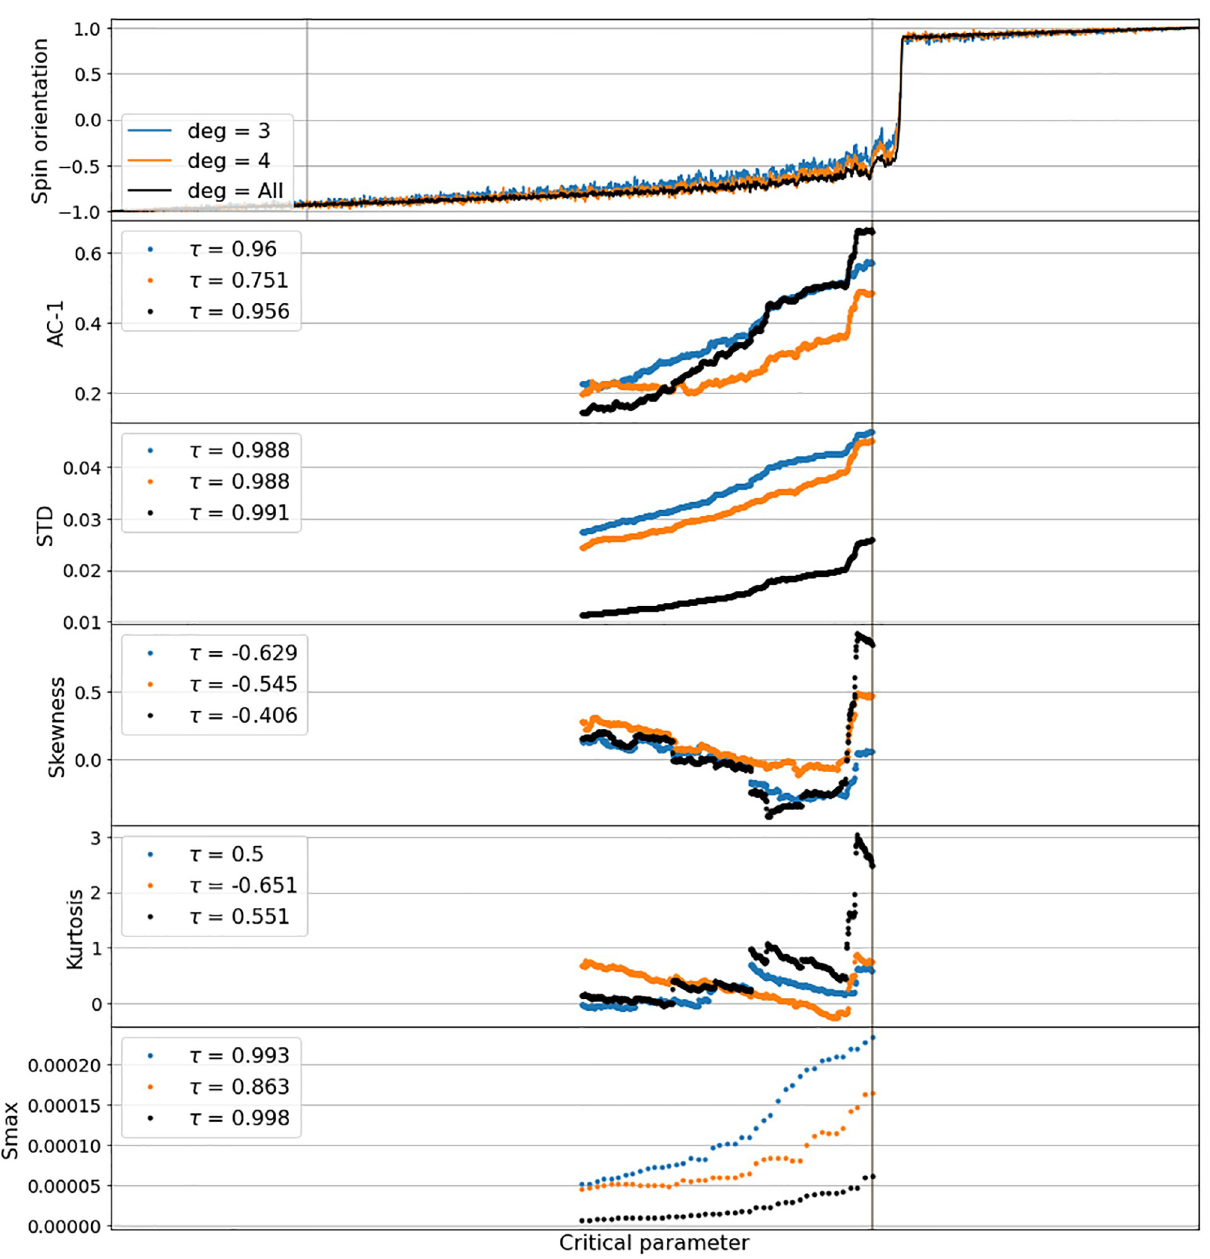
Fig 5. Early Warning Signals of lower-degree nodes in the networked alternative spin-shifting model (as introduced in the preceding section and in [16]), with an assortativity of 0.317, as shown in the leftmost image in Fig 2. The dynamics of two lowest-degree clusters (blue and orange) are compared to the one of the aggregate system (black). In AC-1, Skewness and Kurtosis, the aggregate information eventually exceeds the low-degree signals, but starts to increase later in AC-1 and does not show much difference in Skewness and Kurtosis. And it appears to be less indicative in STD and the peak of the power spectrum (Smax). (all indicators as in Fig